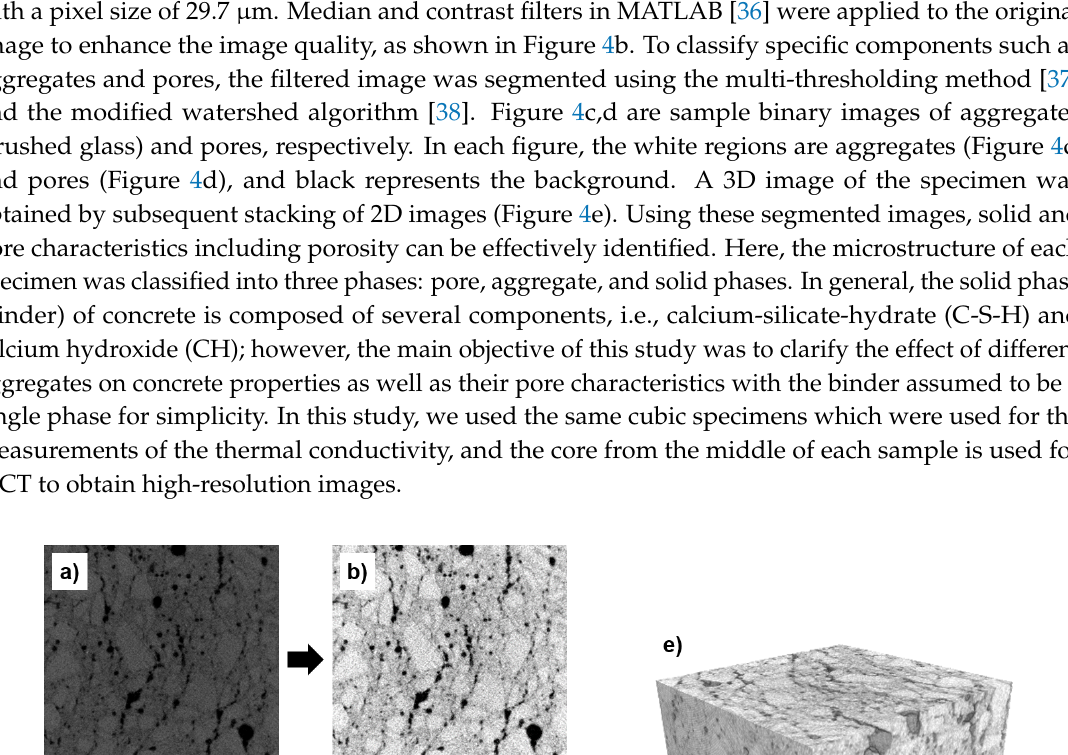
Figure 3. RapidAir 457 device to analyze the pore characteristics